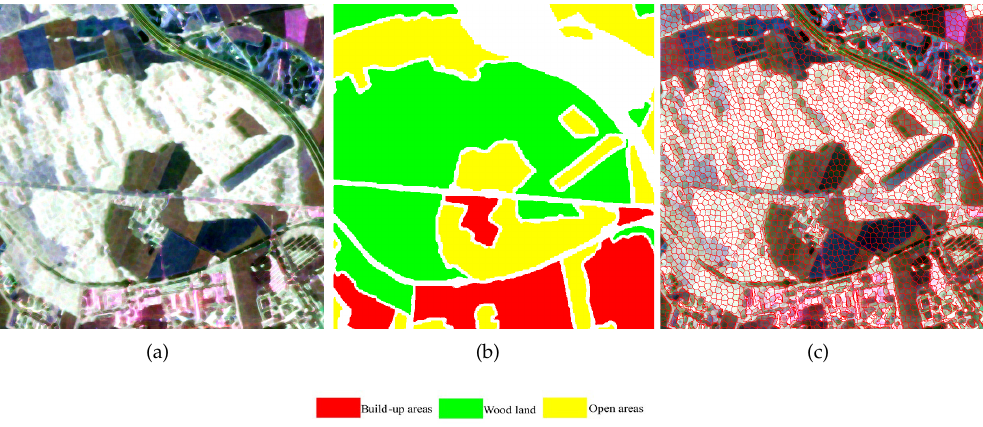
Figure 3. Display of the Oberpfaffenhofen data set. ( a ) the PauliRGB image, ( b ) the corresponding ground truth and ( c ) the segmentation